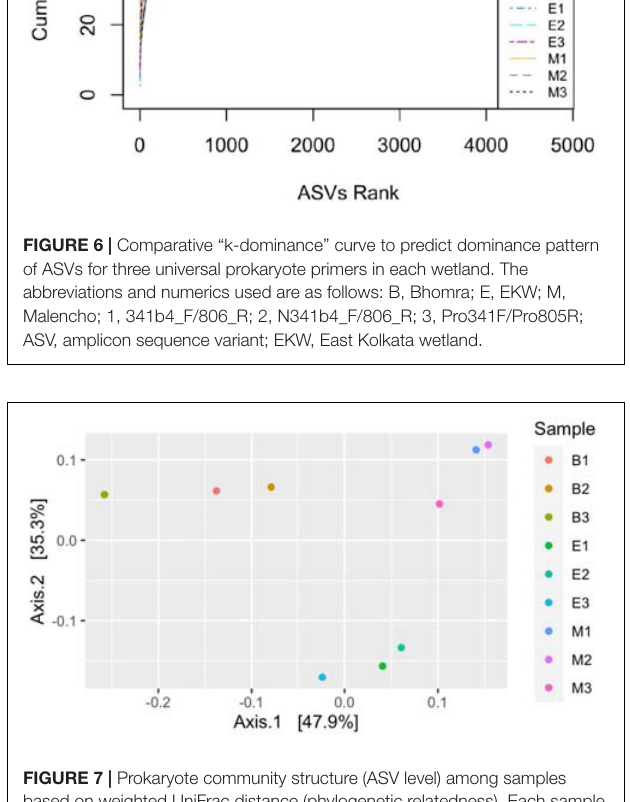
FIGURE 7 | Prokaryote community structure (ASV level) among samples based on weighted UniFrac distance (phylogenetic relatedness). Each sample is represented as a dot and is colored distinctly based on wetland sediment and primer combination. The abbreviations and numerics used are as follows: B, Bhomra; E, EKW; M, Malencho; 1, 341b4_F/806_R; 2, N341b4_F/806_R; 3, Pro341F/Pro805R; ASV, amplicon sequence variant; EKW, East Kolkata